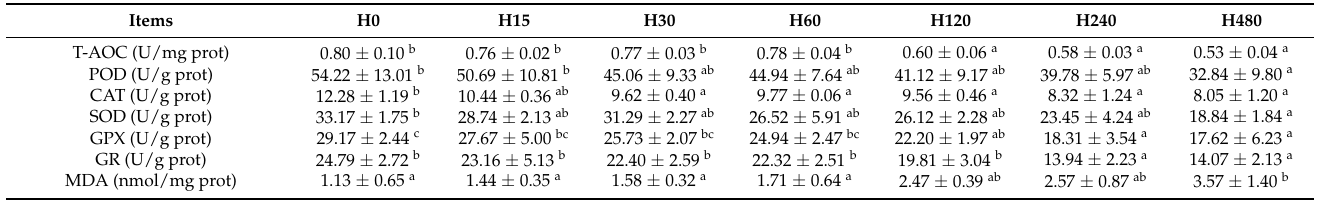
Table 5. Effect of dietary histamine on the intestinal antioxidant ability of striped catfish.